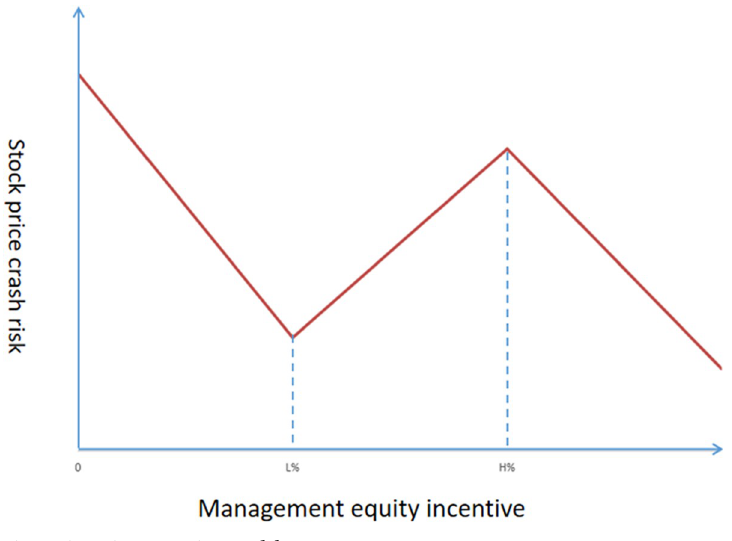
Fig 1. Piecewise regression